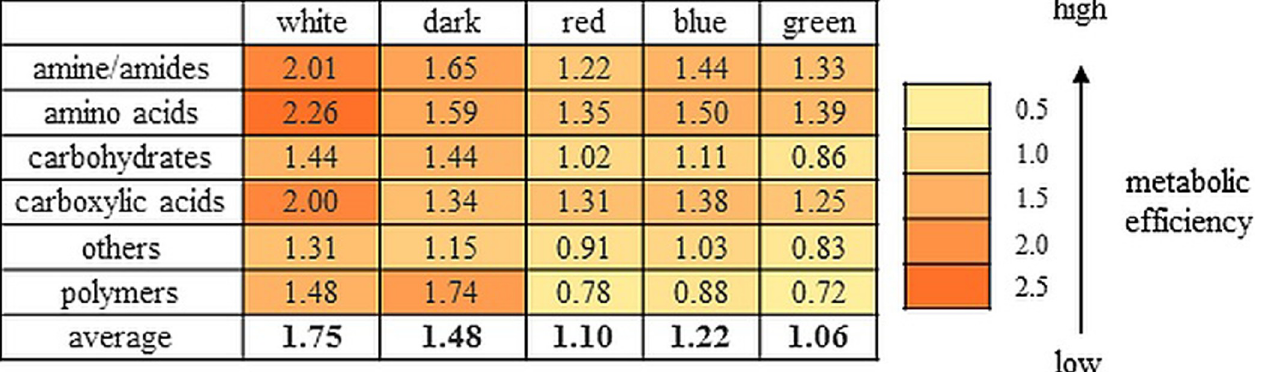
PLOS ONE | https://doi.org/10.1371/journal.pone.0211744 February 5,